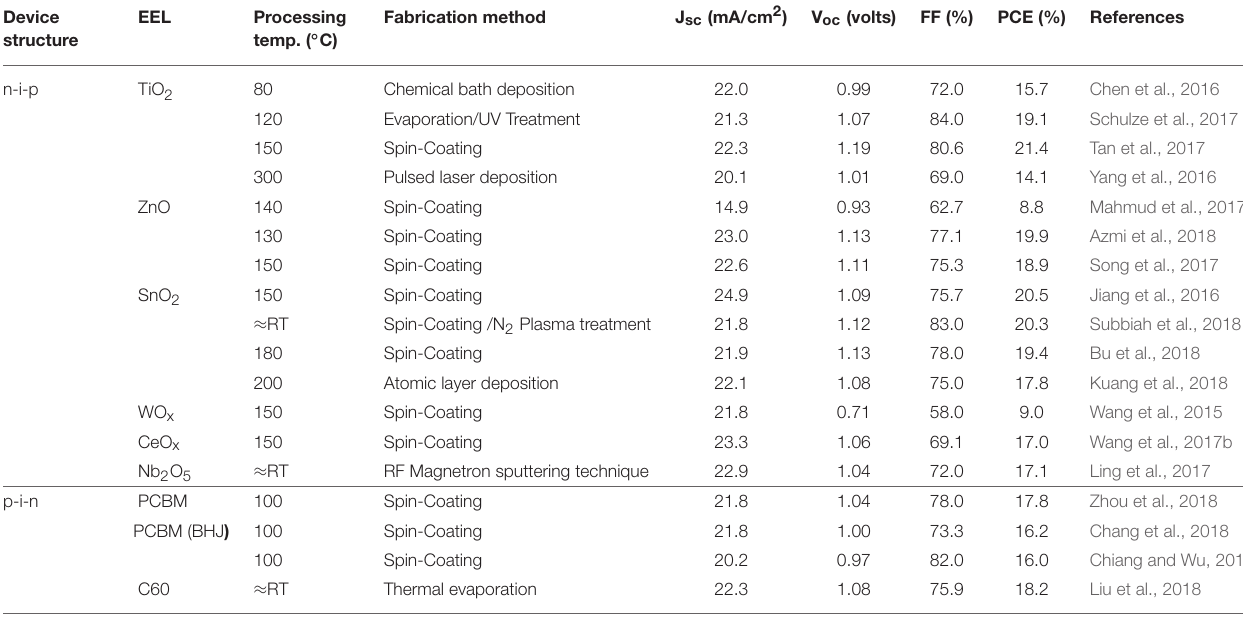
TABLE 1 | List of state-of-the-art PSC based on EEL prepared by the low-temperature process. Device